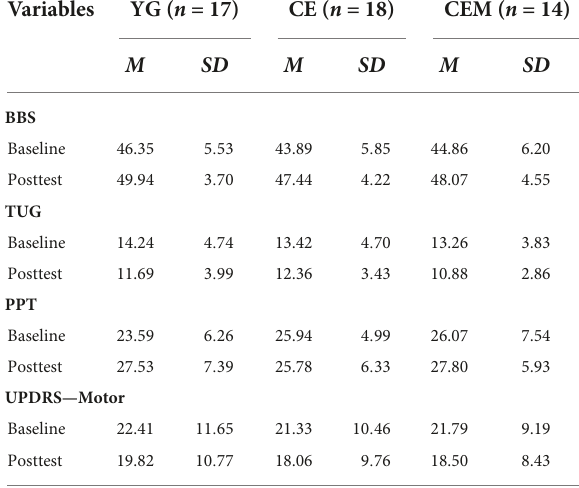
TABLE 2 Descriptive statistics for dependent